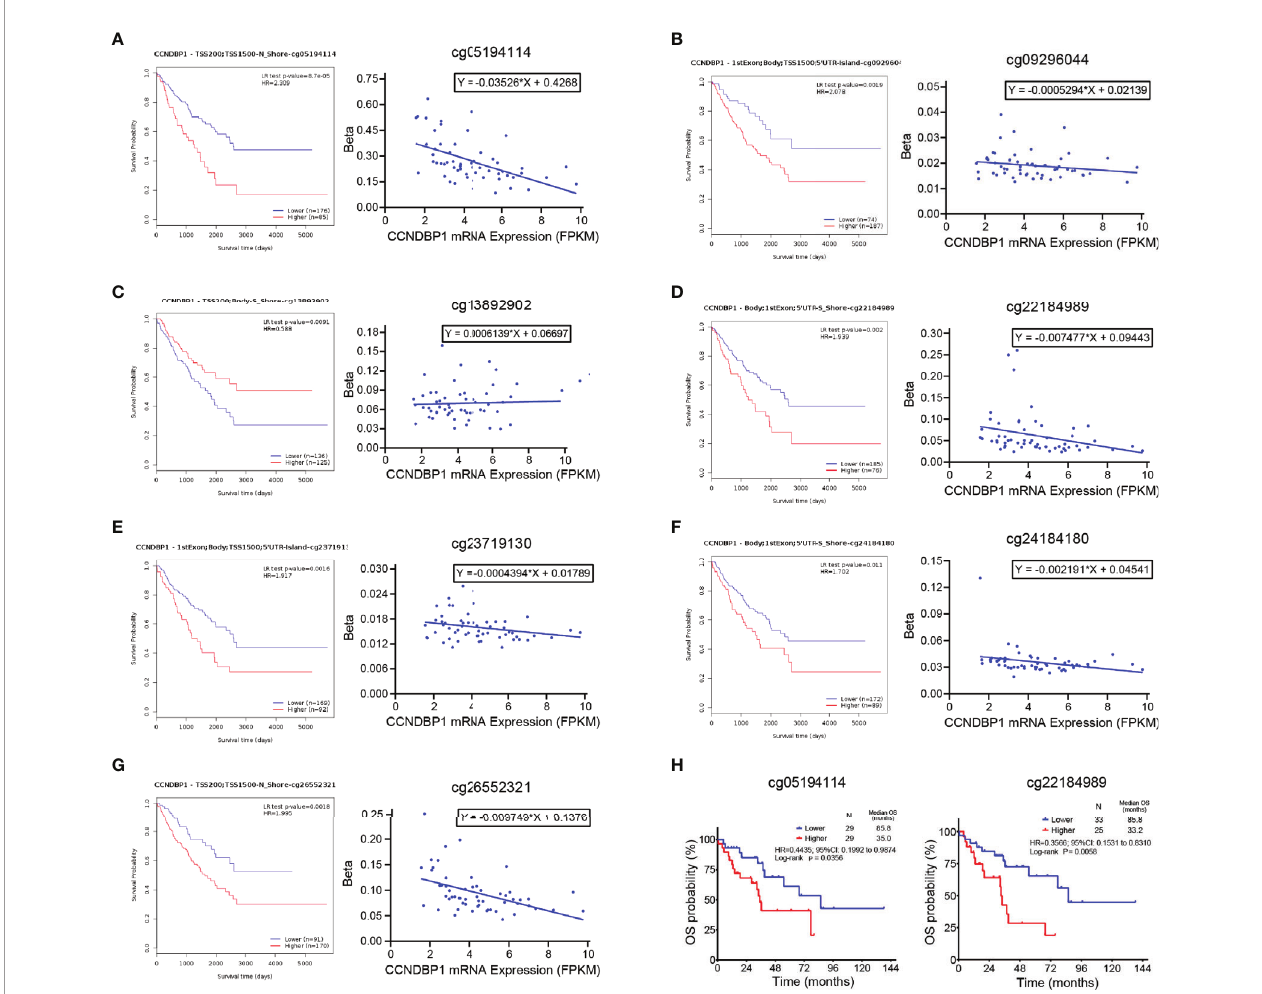
FIGURE 7 | Methylation degrees of DNA methylation sites of CCNDBP1 in fl uenced its expression and prognosis of DDL patients. (A – G) 7 DNA methylation sites of CCNDBP1 related with the prognosis of sarcoma patients. Among them, the beta values of (A) cg05194114, (B) cg09296044, (D) cg22184989, (E) cg23719130, (F) cg24184180, and (G) cg26552321 were negatively correlated with CCNDBP1 expression, the larger the beta value, the worse the prognosis; the beta value of cg13892902 (C) was positively correlated with CCNDBP1 expression, the larger the beta value, the better the prognosis. (H) The survival curve of DNA methylation degrees of cg05194114 (with the beta value of 0.2389 as the boundary) and cg22184989 (with the beta value of 0.04997 as the boundary) in fl uenced the OS of DDL patients in TCGA database, the higher the methylation degrees of these two sites, the worse the prognosis of DDL